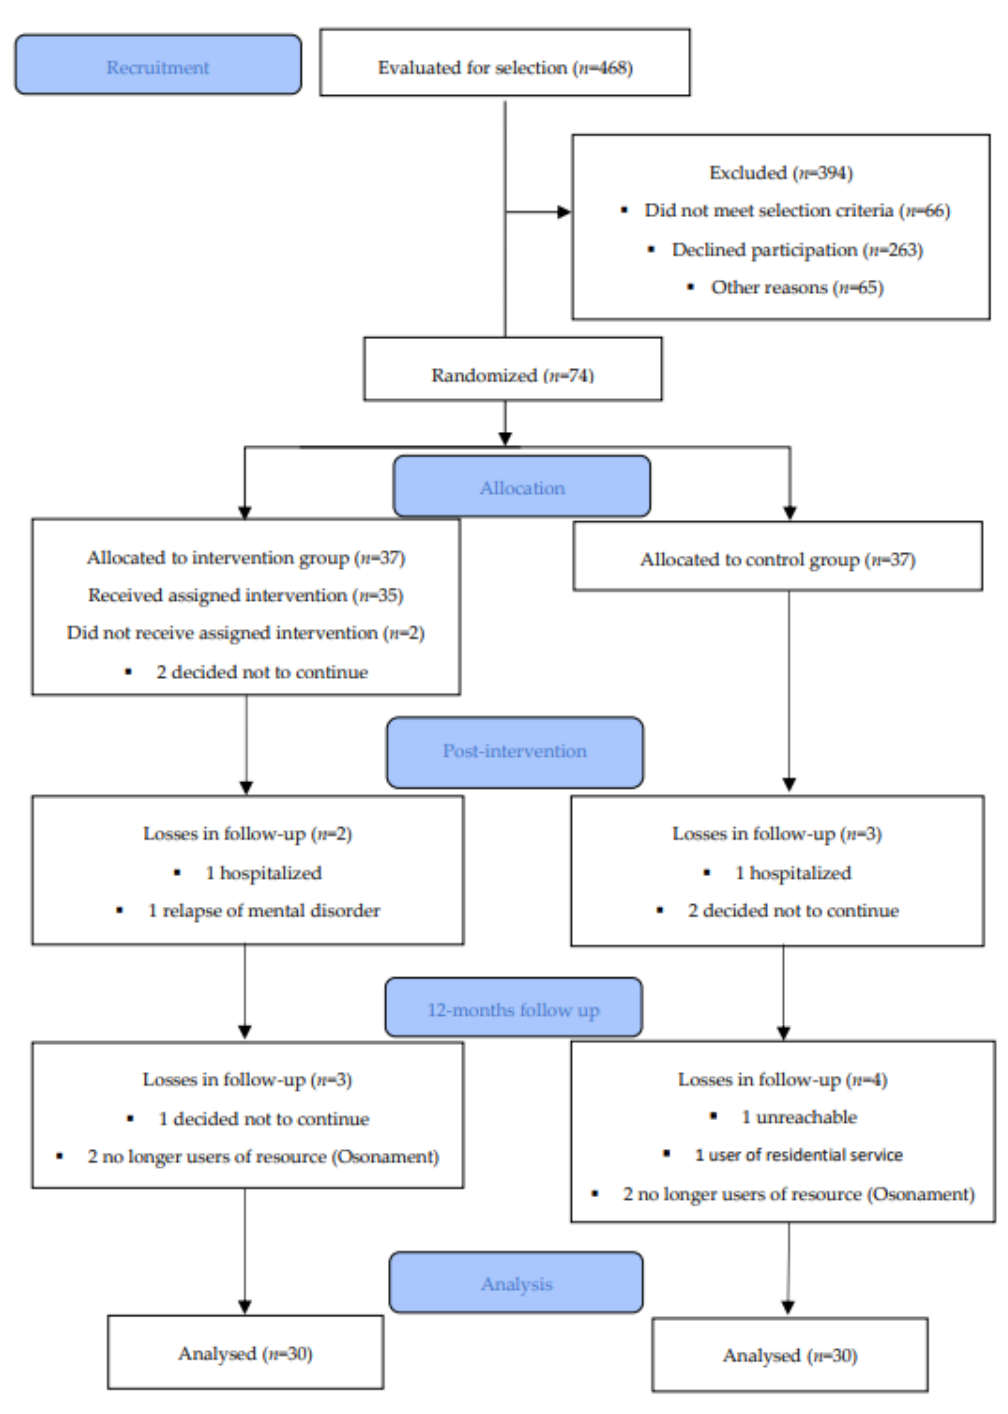
Figure 1. Participation flow chart (CONSORT 2010).